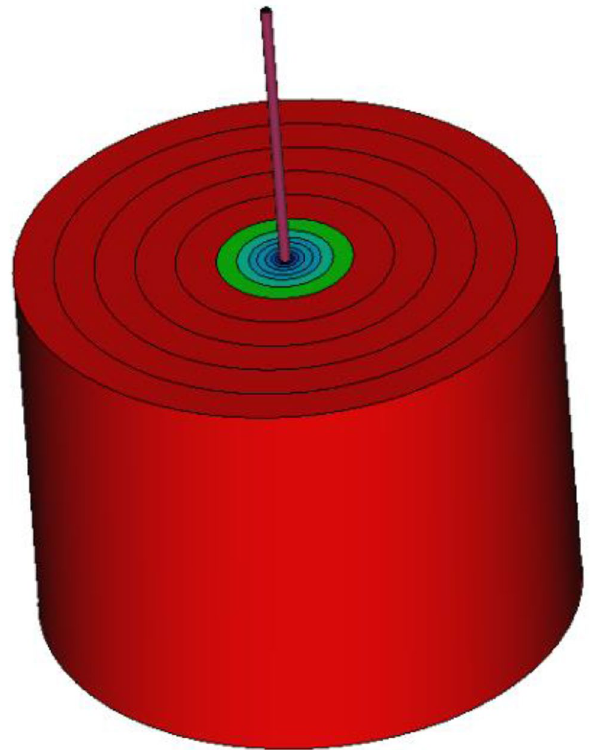
Fig. 2 Schematic of the